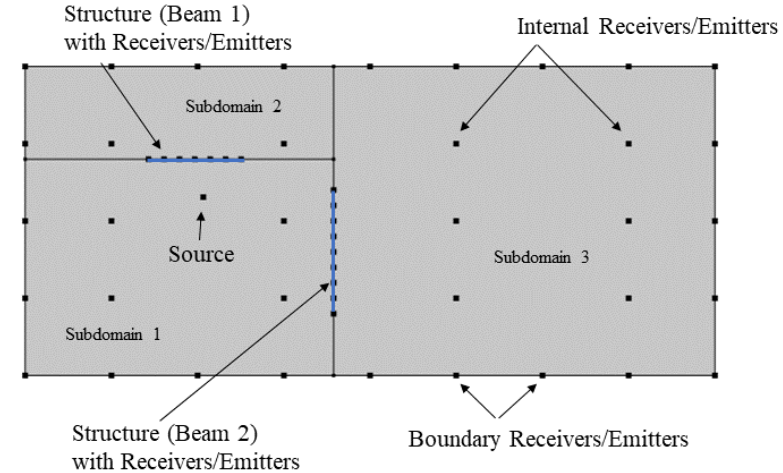
Figure 3. The domain with two beams immersed in the fluid and 48 receivers/emitters in total.